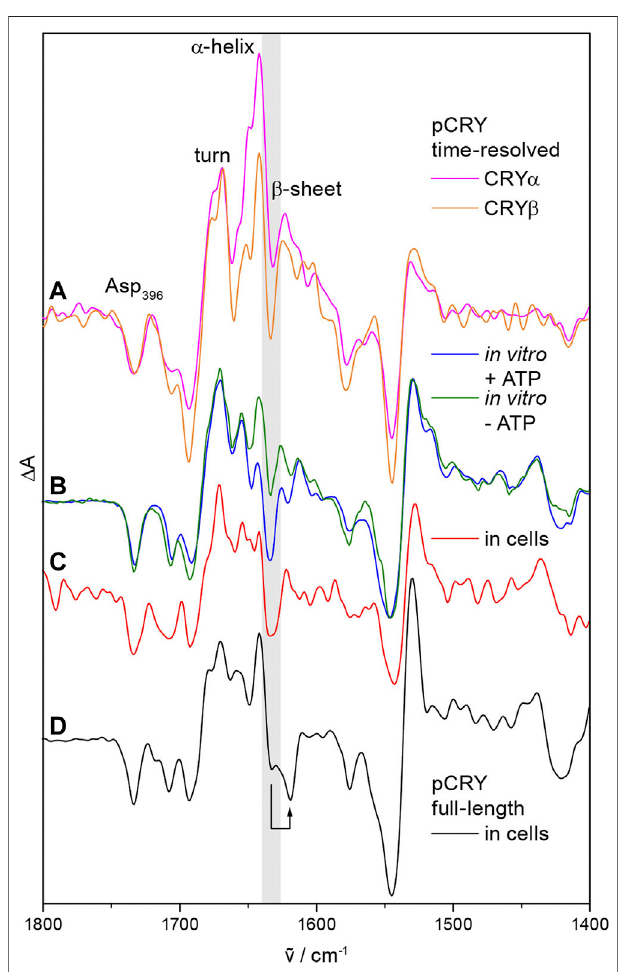
FIGURE 3 | Conformational changes in pCRY observed by time- resolved,staticand in-cellinfrared difference spectroscopy. (A) Time resolved step-scan experiments on the PHR domain detected an increase in α -helical andturnelements,whichischaracteristicfortheintermediateCRY α with a lifetime of 500 µs. Subsequently, a loss of β -sheet content is detected representing the intermediate CRY β (highlighted in gray) with a lifetime of 29 ms. (B) The presence of ATP stabilizes the CRY β intermediate in vitro into the time range of minutes as observed by static experiments. (C) Similarly, cellular nucleotides stabilize CRY β in bacterial cells as determined by in-cell spectroscopy. (D) Full-length pCRY shows a shift of the β -sheet signal attributed to the association of the CCT close to the β -sheet of the PHR as shown by in-cell spectroscopy. Spectra were taken from (Thöing et al., 2015; Schroeder et al., 2018; Goett-Zink et al.,